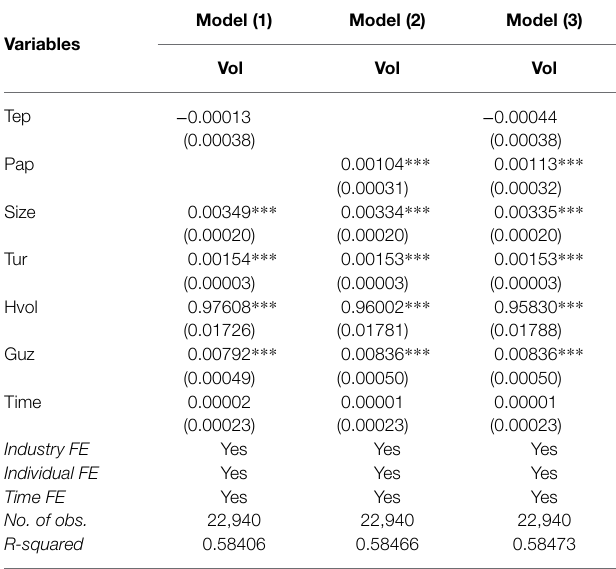
TABLE 8 | Robustness checks for random